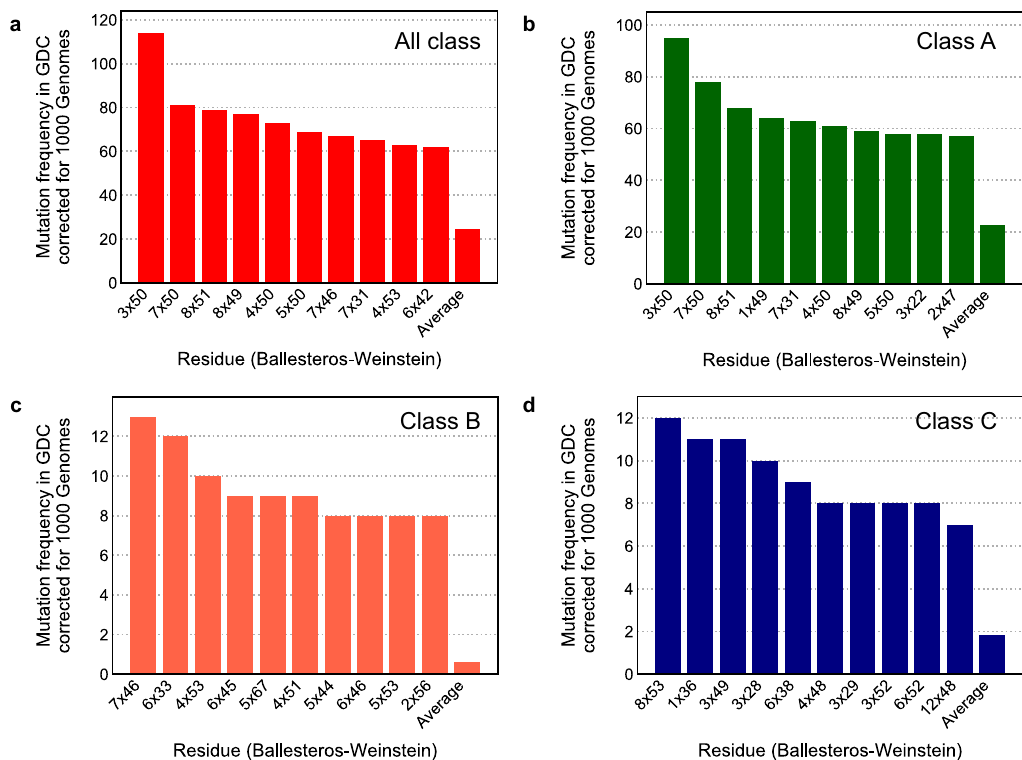
Figure 4. Most frequently mutated residues in GDC corrected for natural variance. The 10 positions with the highest mutation frequency in GPCRs in the GDC dataset corrected for the mutation frequency in the 1000 Genomes dataset. ( a ) Analysis of all GPCR classes combined. ( b ) Analysis of Class A GPCRs. ( c ) Analysis of Class B GCPRs. ( d ) Analysis of Class C GPCRs. The residue location in Ballesteros-Weinstein notation is shown on the x-axis, while on the y-axis the corrected mutation frequency of that residue is given. “Average” is the average mutation frequency per residue over all the